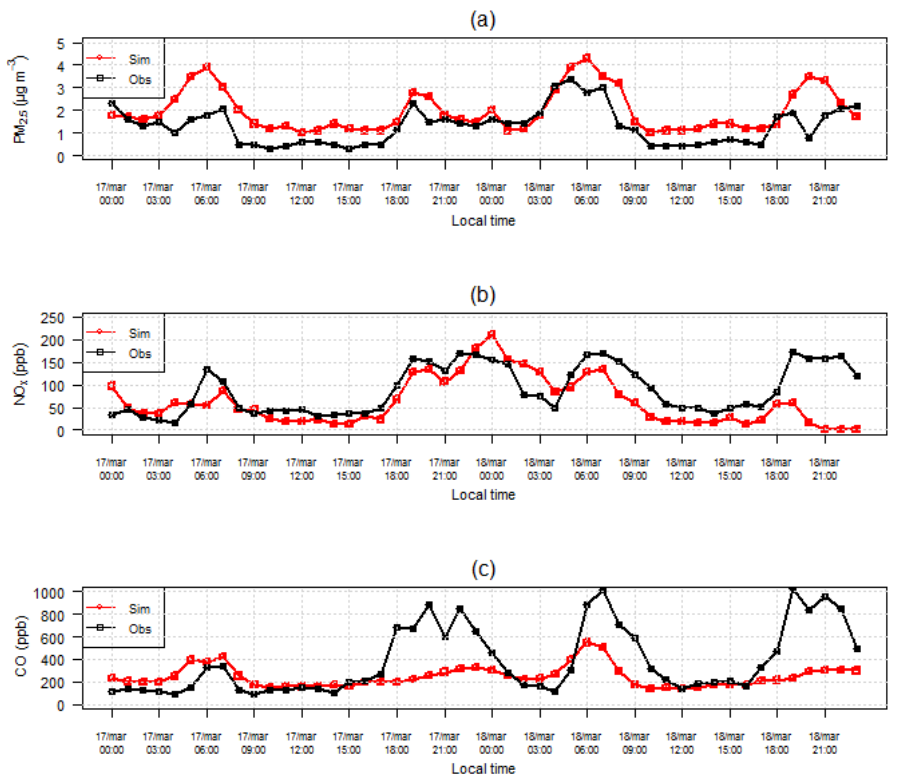
Figure 5. Temporal evaluation of simulated and observed values for the concentration of pollutants at T1: (a) PM 2 . 5 , (b) NO x and (c)